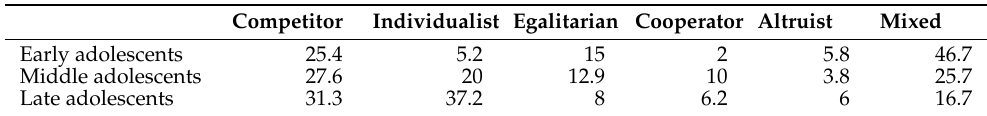
Table 3. Participants’ SVO Across Three Age Groups